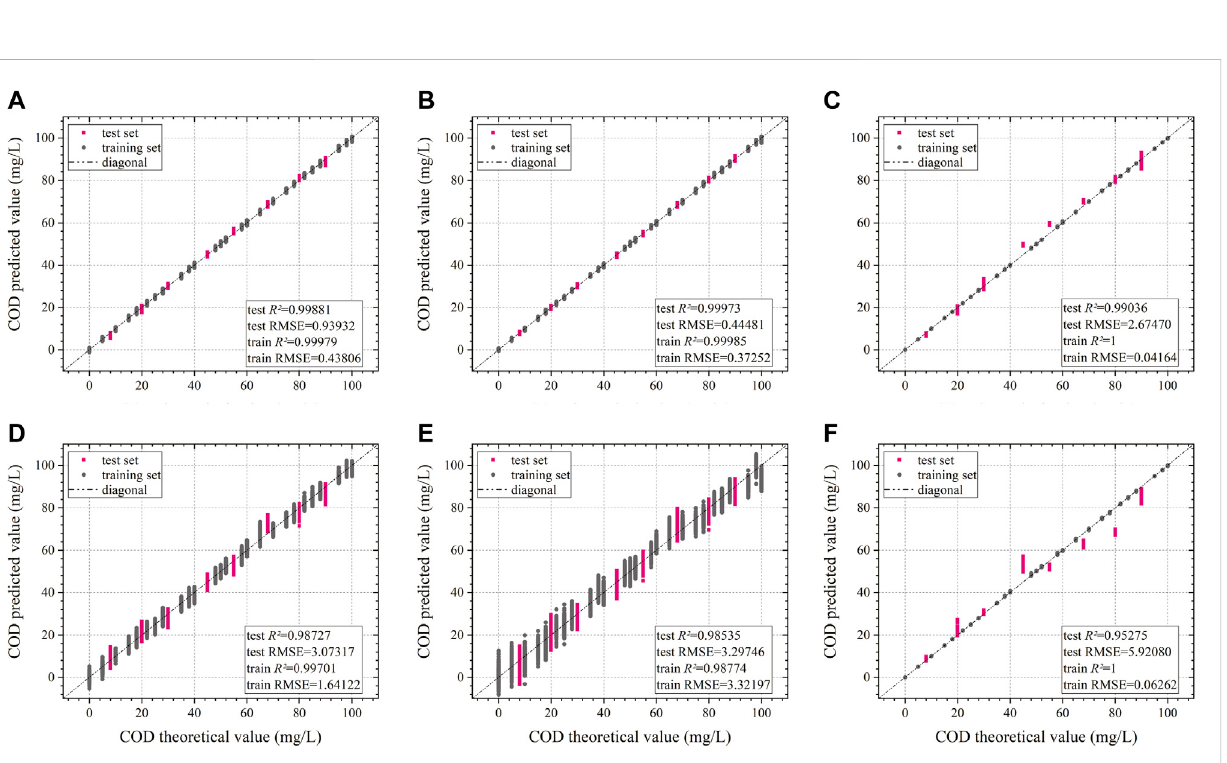
FIGURE 6 Comparison curves between predicted and theoretical COD values in the training set and test set of six models. (A) The model of PLSR in transmissivedetection. (B) ThemodelofSVRintransmissivedetection. (C) ThemodelofRFRintransmissivedetection. (D) ThemodelofPLSRinre fl ective detection. (E) The model of SVR in re fl ective detection. (F) The model of RFR in re fl ective